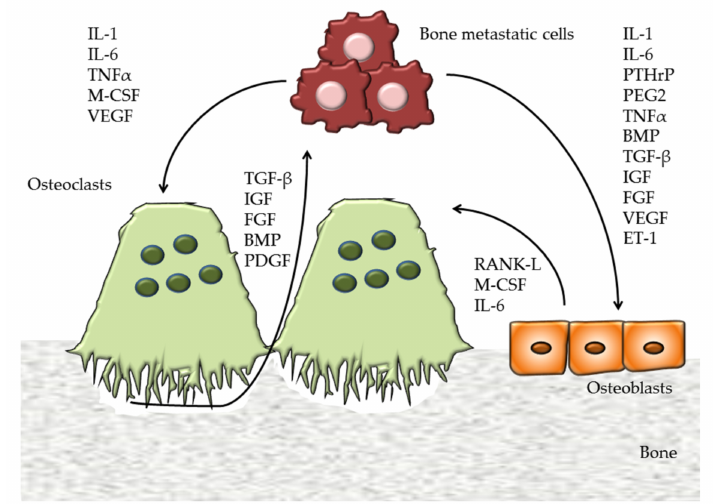
Figure 1. Vicious cycle of bone metastasis. Tumor cells destroy the virtuous cycle of bone remodeling stimulating osteoclast differentiation and activity by the secretion of IL-1 (Interleukin 1), IL-6 (Interleukin 6), TNF α (Tumor Necrosis Factor alpha), M-CSF (Macrophage Colony Stimulating Factor), and VEGF (Vascular Endothelial Growth Factor). TGF- β (Transforming Growth Factor beta), IGF (Insulin Growth Factor), FGF (Fibroblast Growth Factor), BMP (Bone Morphogenetic Protein), and PDGF (Platelet Derived Growth Factor) are released from the bone matrix during bone resorption and stimulate tumor cells. Bone metastastic cells influence osteoblast activity by IL-1, IL-6, PTHrP (Parathyroid hormone-related protein), PEG2 (Prostaglandin E2), TNF α , ET-1 (Endothelin-1), BMP, and various growth factors. In turn, osteoblasts secrete factors that stimulate osteoclastogenesis, including RANK-L (Receptor activator of nuclear factor kappa-B ligand), M-CSF, and